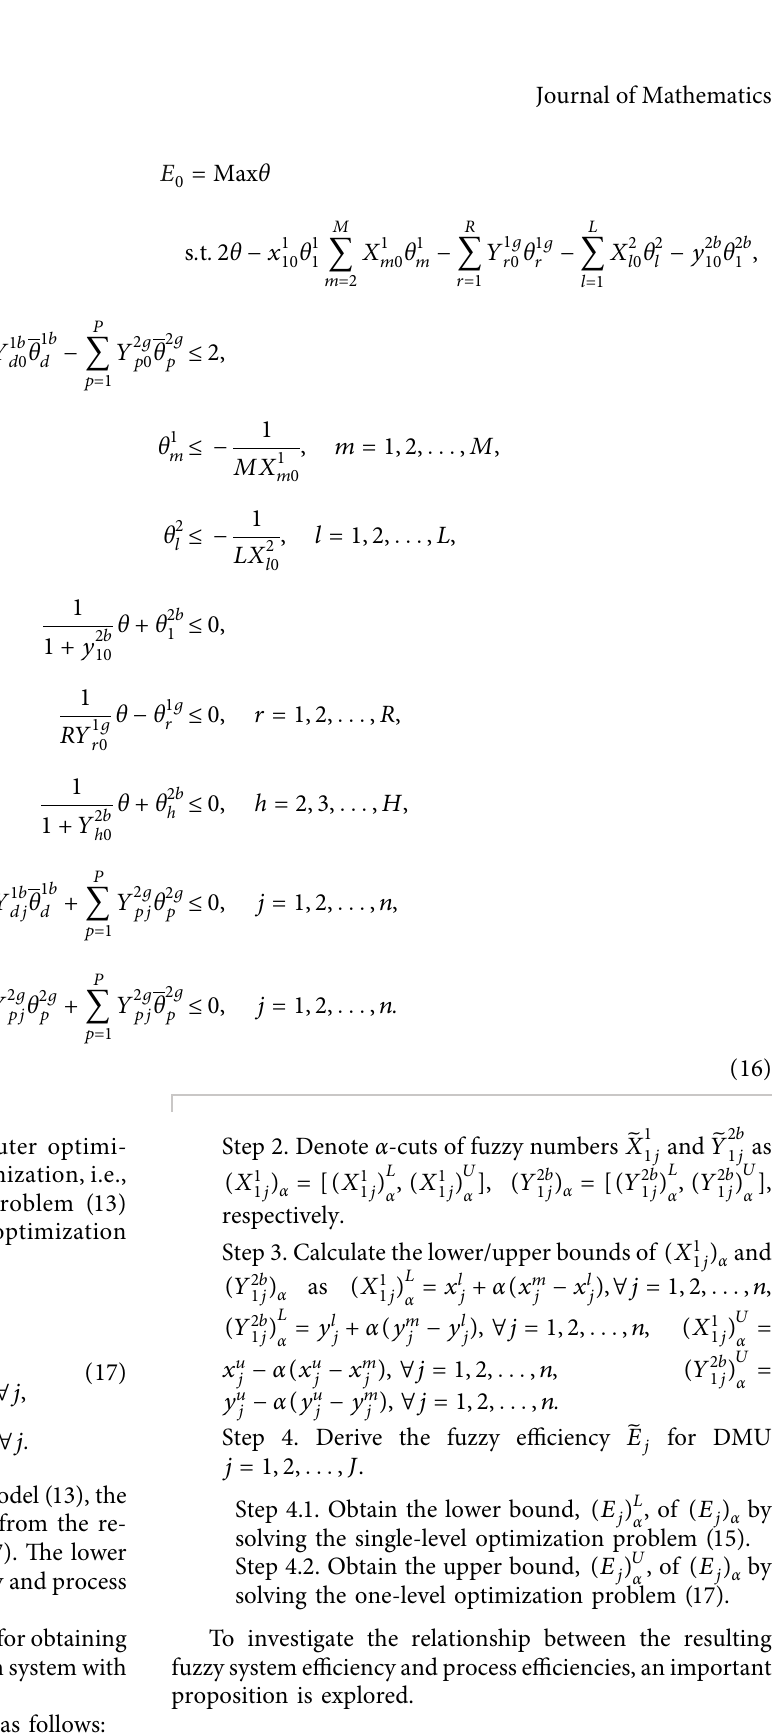
fuzzy system efficiency is the weighted average of the lower/ upper bounds of the α-cuts of its fuzzy process